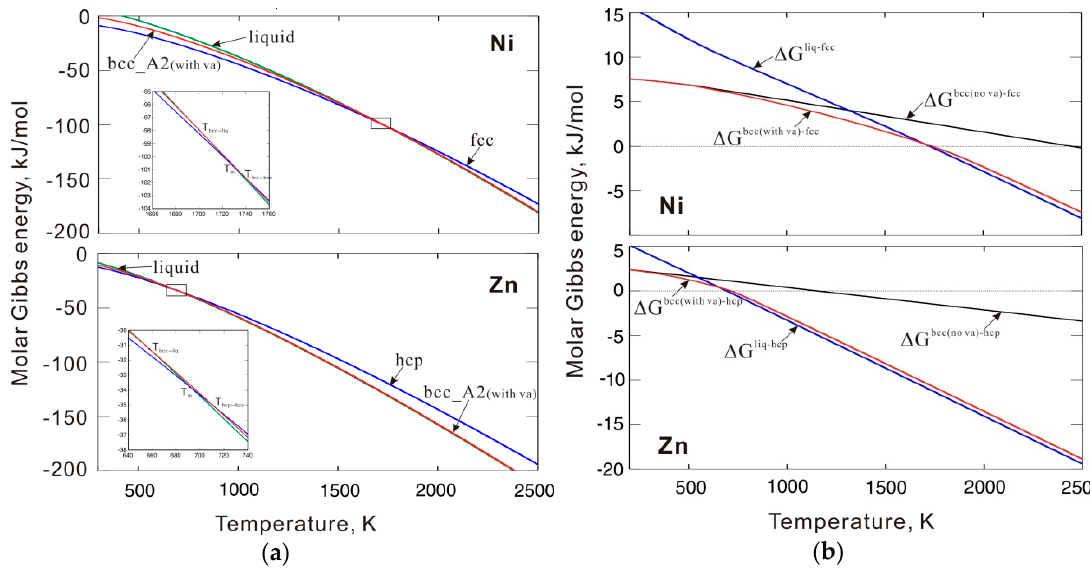
Figure 4. ( a ) Molar Gibbs energy of bcc_A2 with a thermal vacancy along with those of liquid and reference phases for pure Ni and Zn; ( b ) Molar Gibbs energy of bcc_A2 with and without a thermal vacancy and liquid phases for pure Ni and Zn related to the reference states. Here, ∆ G denotes differences of Gibbs energy between two phases (for instance ∆ G liq − fcc = G liquid − G fcc ). The reference states are fcc Ni and hcp Zn, respectively.